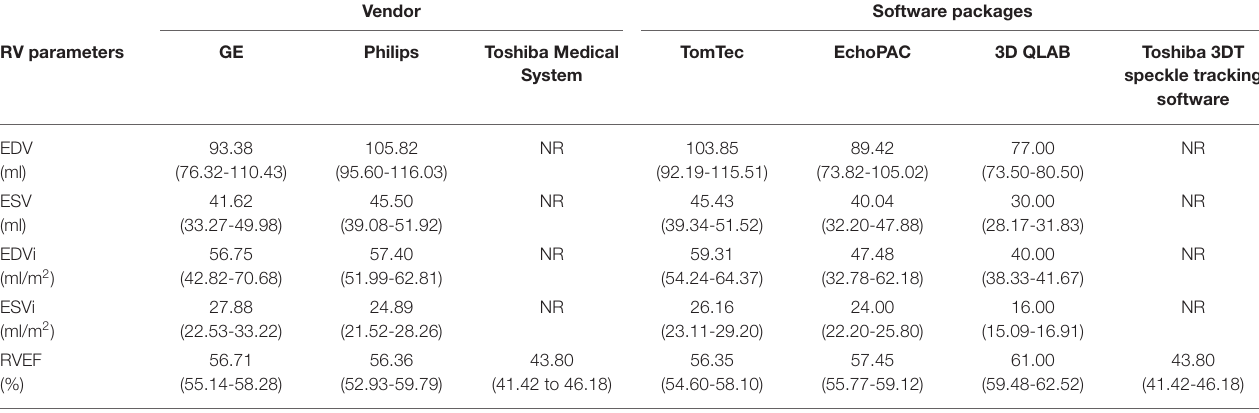
TABLE 3 | Vendor- and software-specific reference values for RV volumes and RVEF by 3DE. Vendor